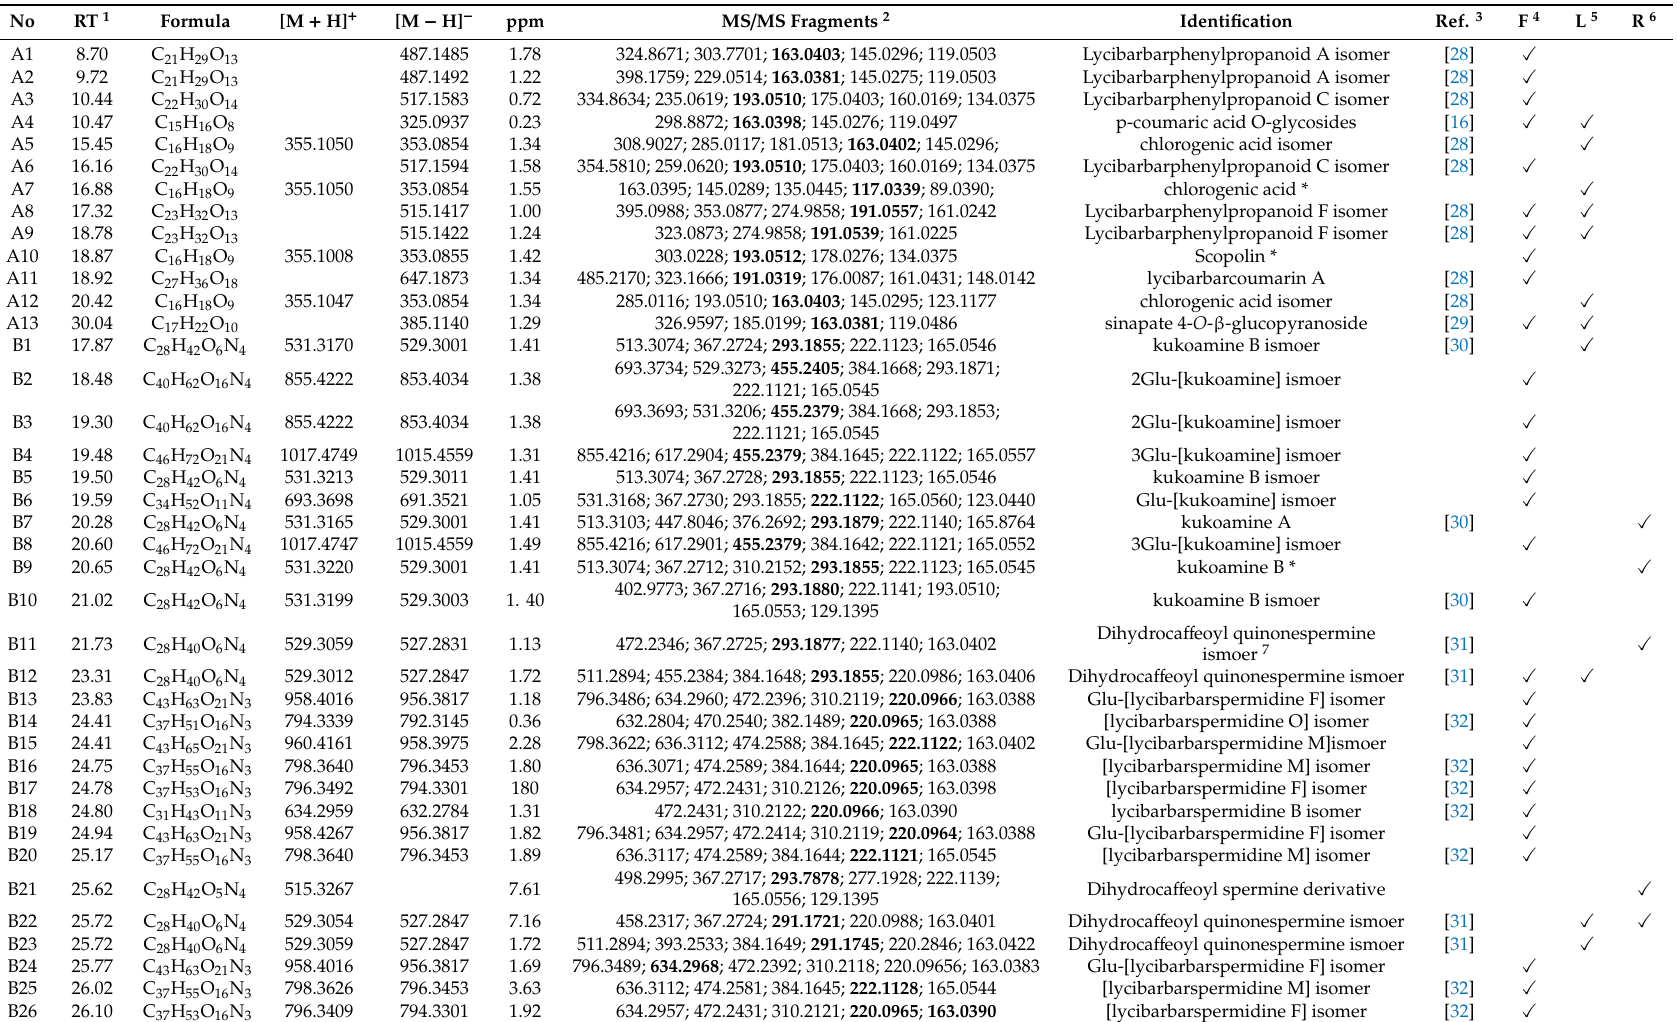
Table 1. Compounds identified from fruits, leaves and root barks of L. barbarum by UPLC-Q-Orbitrap-MS /